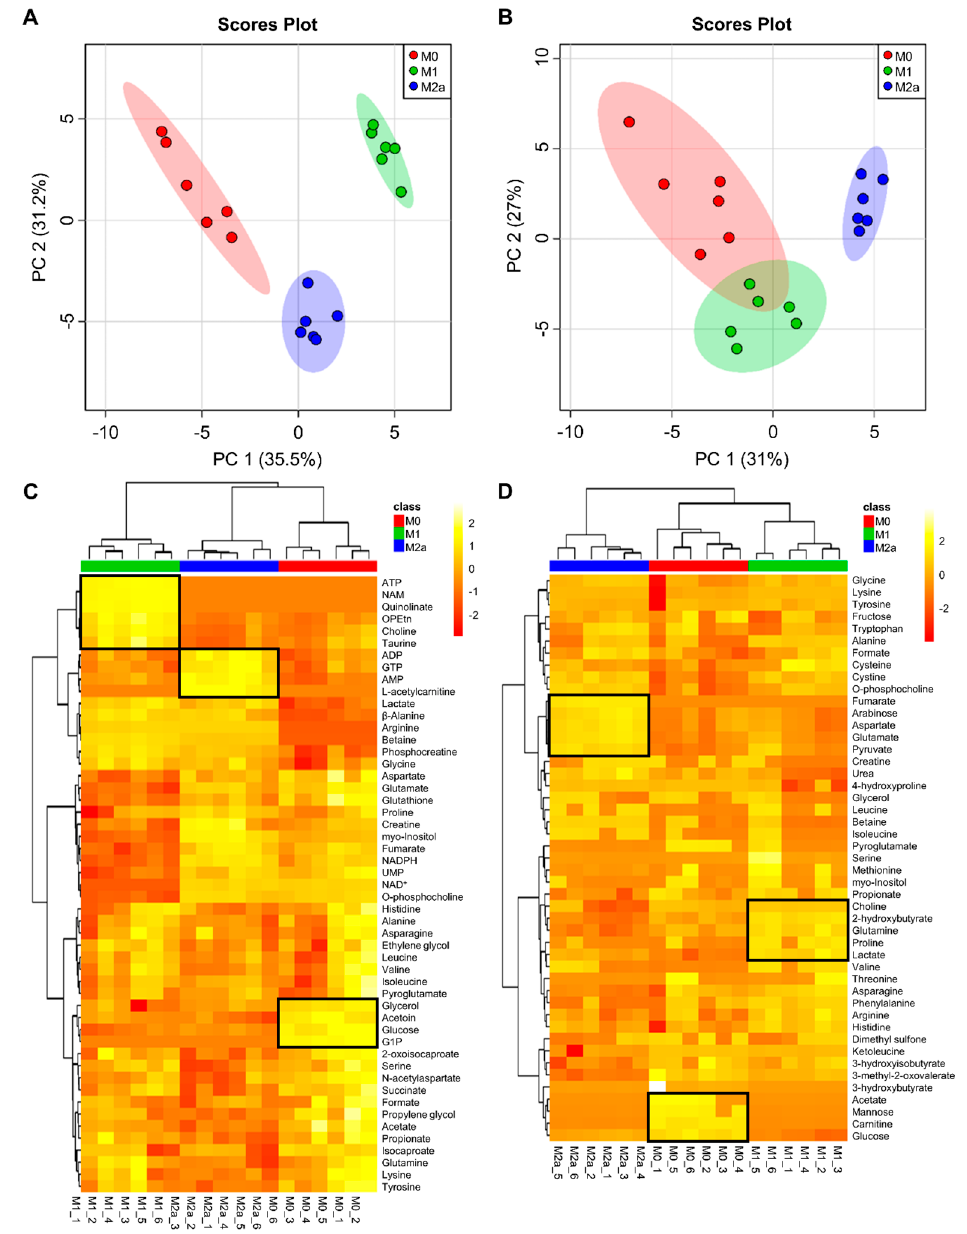
Figure 1. Multivariate statistical analysis reveals metabolic differences between macrophage (M Φ ) activation states. Two-dimensional principal component analysis (2D-PCA) scores plots generated by analysis of metabolic profiles from intra- ( A ) and extracellular ( B ) M Φ metabolite extracts (M0, red; M1, green; M2a, blue), with shaded regions illustrating respective 95% confidence intervals. Hierarchical clustering analysis (HCA) and heatmap visualization of metabolic profiles from intra- ( C ) and extracellular ( D ) M Φ metabolite extracts were performed using a Euclidean distance calculated from metabolite abundance and a Ward clustering algorithm. The upmost column bar is colored according to the M Φ activation state (M0, red; M1, green; M2a, blue), and the color scale represents the scaled abundance of each metabolite, with yellow indicating high abundance and red indicating low abundance. Particular sets of discriminatory metabolites are highlighted in boxed regions on the heatmaps. Abbreviations denote: ADP, adenosine diphosphate; AMP, adenosine monophosphate; ATP, adenosine triphosphate; G1P, glucose-1 phosphate; GTP, guanosine triphosphate; NAD + , nicotinamide adenine dinucleotide; NADPH, reduced nicotinamide adenine dinucleotide phosphate; NAM, niacinamide; OPEtn, o-phosphoethanolamine; UMP, uridine monophosphate.